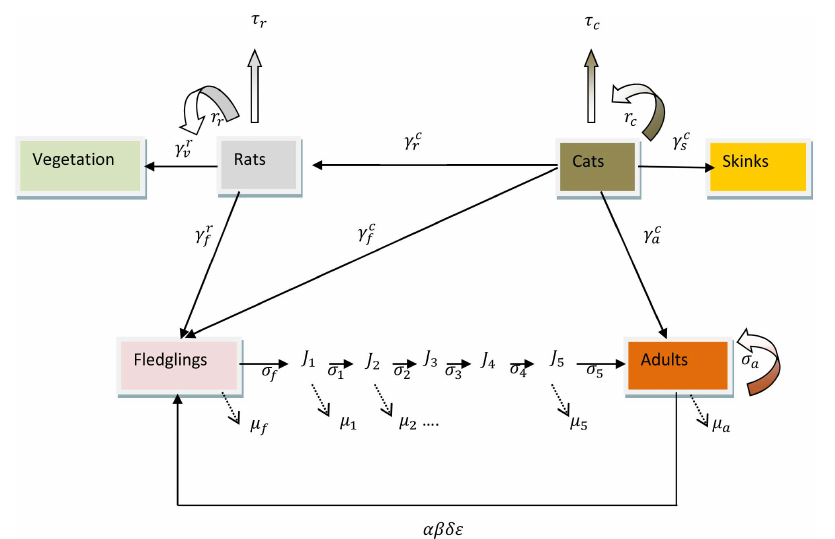
is the predation rate of population i on j